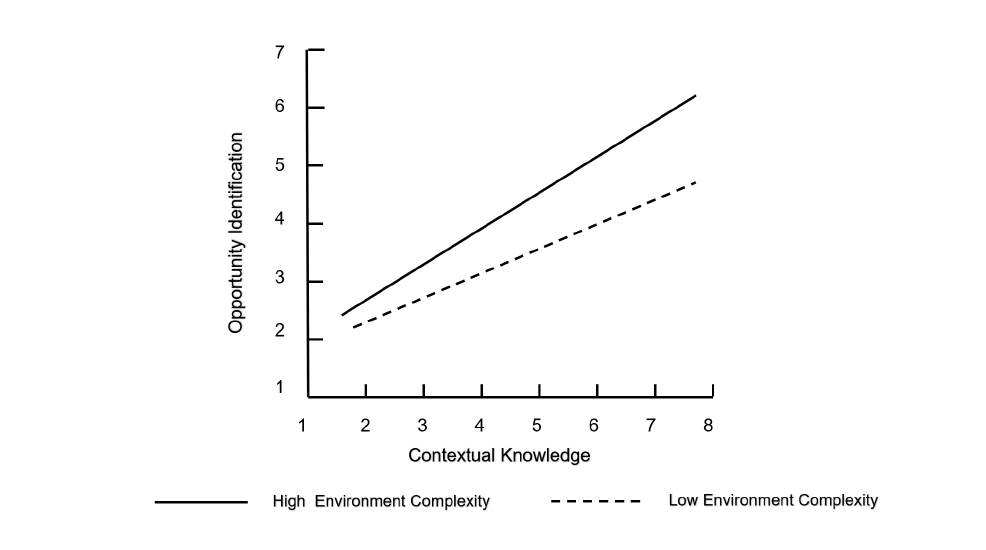
Fig. 2 The moderating role of environment complexity on the relationship between CK and opportunity identification.